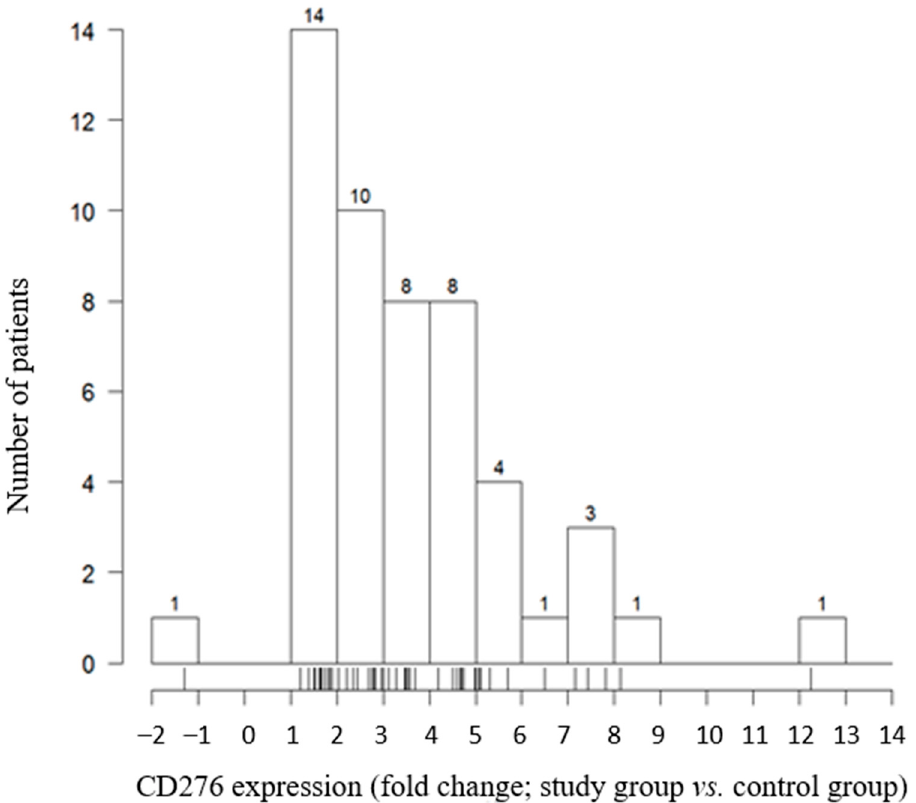
Figure 1. CD276 expression by tumor cells.